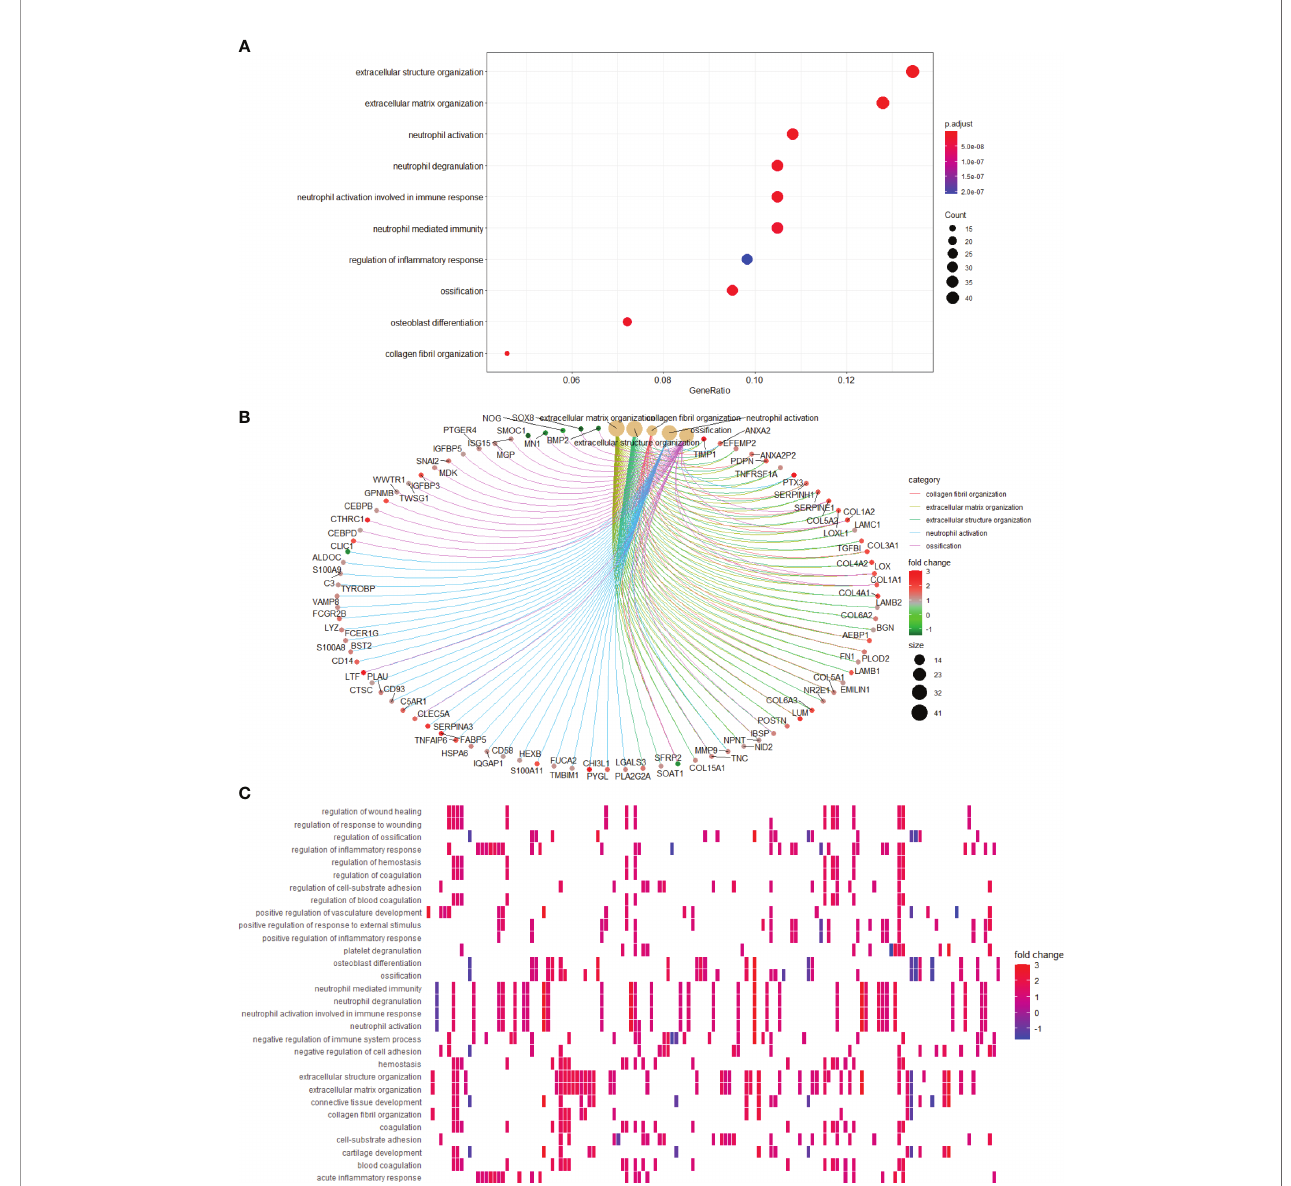
FIGURE 10 | Pathways correlating with LGALS expression. (A) Pathway enrichment analysis showed high LGALSs expression correlated with several pathways. (B) Genes that belong to top 5 pathways are shown. (C) Pathways correlate with high LGALS